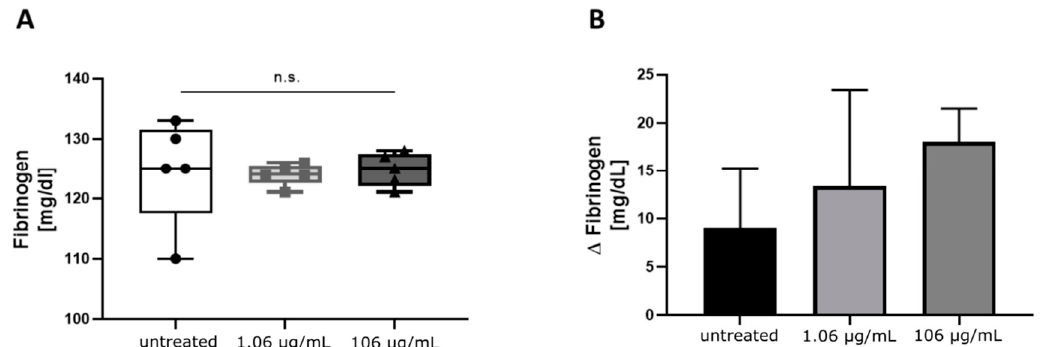
Figure 3. Functional levels of fibrinogen in samples ( n = 5) of the plasma exchange experiment with cell culture supernatants as determined by Clauss compared to immunologically measured fibrinogen concentrations. ( A ) Fibrinogen levels were detected with Clauss method in supernatants of HepG2 treated with the indicated concentrations of tigecycline and mixed with normal platelet-free plasma (PFP). ( B ) Additional to the functional measurement, antigen levels of fibrinogen were assessed. Plotted are the di ff erences between immunologic minus functional levels of fibrinogen ( ∆ fibrinogen) as mean and corresponding standard deviation. Both figures display the cumulative data of supernatants after five to ten days incubation of cells with tigecycline plotted by concentration. Di ff erences between groups were tested by One-Way ANOVA, the alpha error levels were higher than 0.05 in both comparisons.